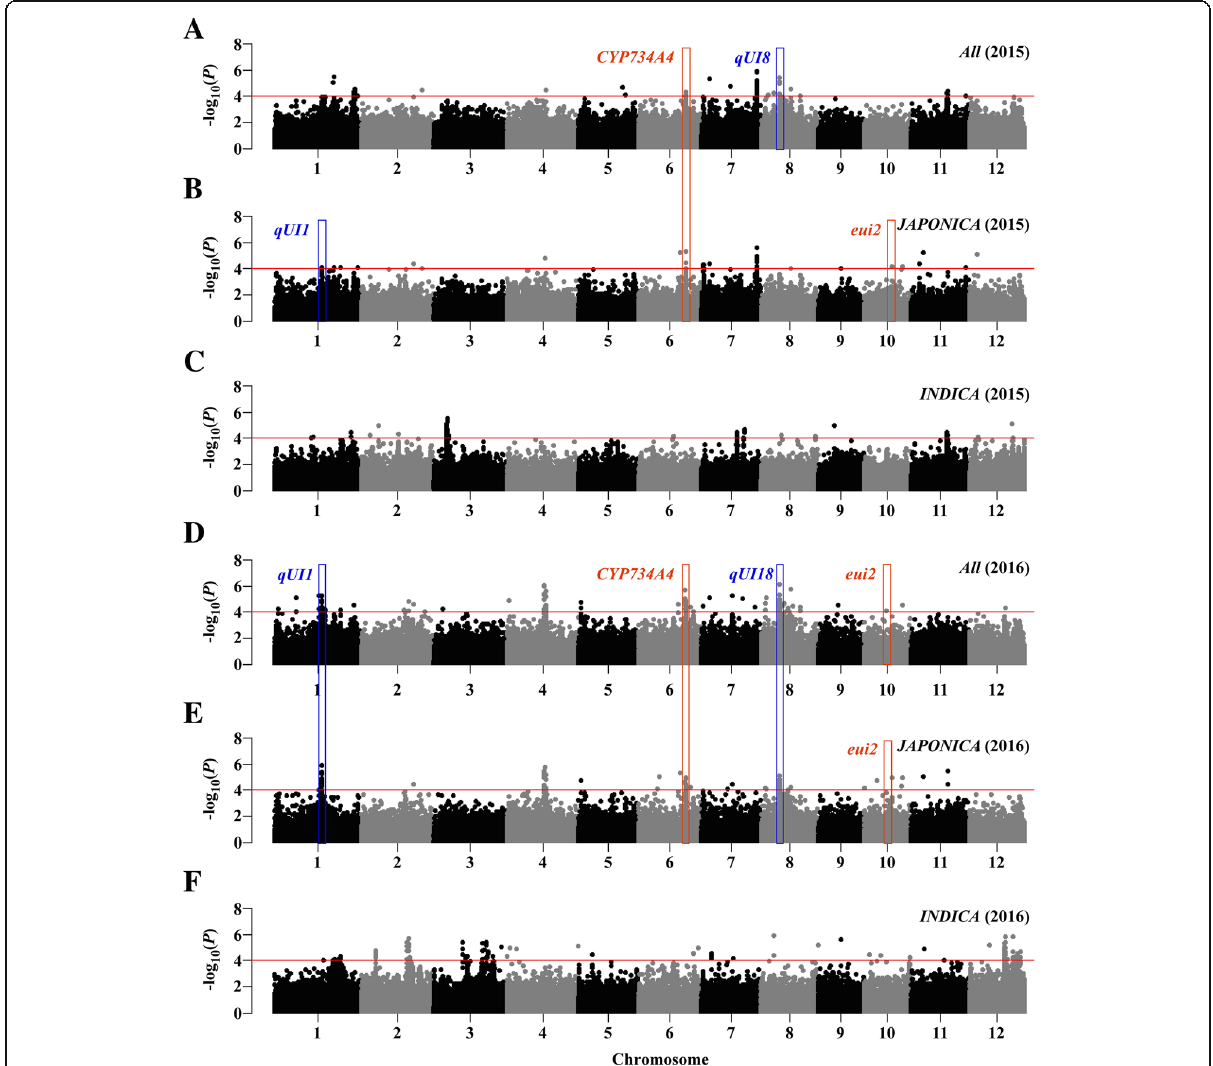
Fig. 3 Genome-wide Manhattan plots of association mapping for UI using the EMMAX model. Associations identified based on All (2015, a ; 2016, d ), JAPONICA (2015, b ; 2016, e ) and INDICA (2015, c ; 2016, f ) groups are depicted in separate panels. The red bar frames indicate that genes are reported, and the blue bar frames indicate the key novel loci co-located in both 2015 and 2016. The x axis depicts the physical location of SNPs across 12 chromosomes of rice, and the y axis depicts -log 10 ( P value). Significant SNPs with P ≤ 0.0001 are denoted as red